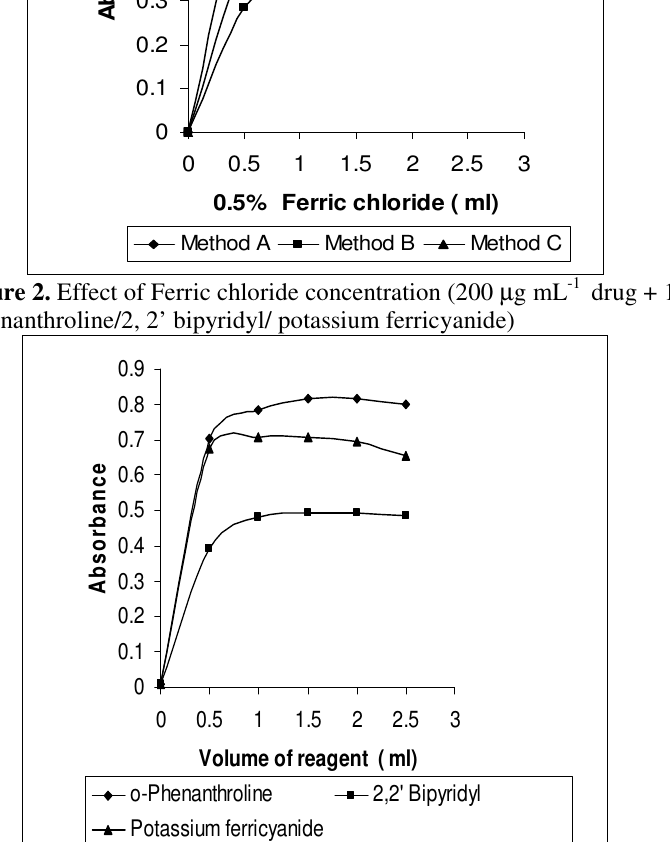
Figure 3. Effect of reagent concentration (200 m g mL -1 drug + 1.0 mL of ferric chloride for methods A&C and 1.5 mL for method